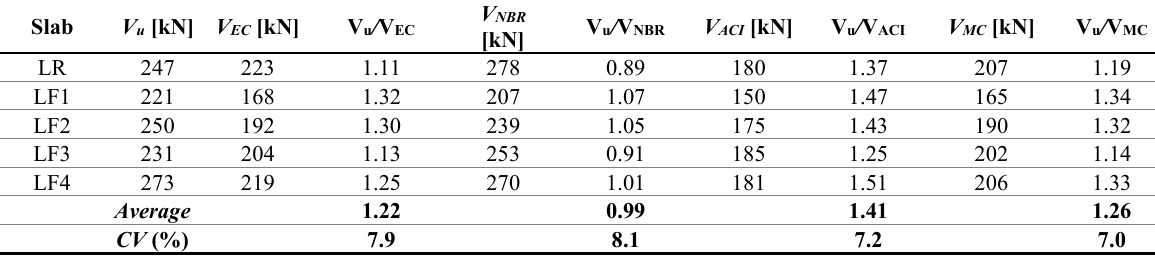
Table 6. Comparison of analytical punching capacity with experimental